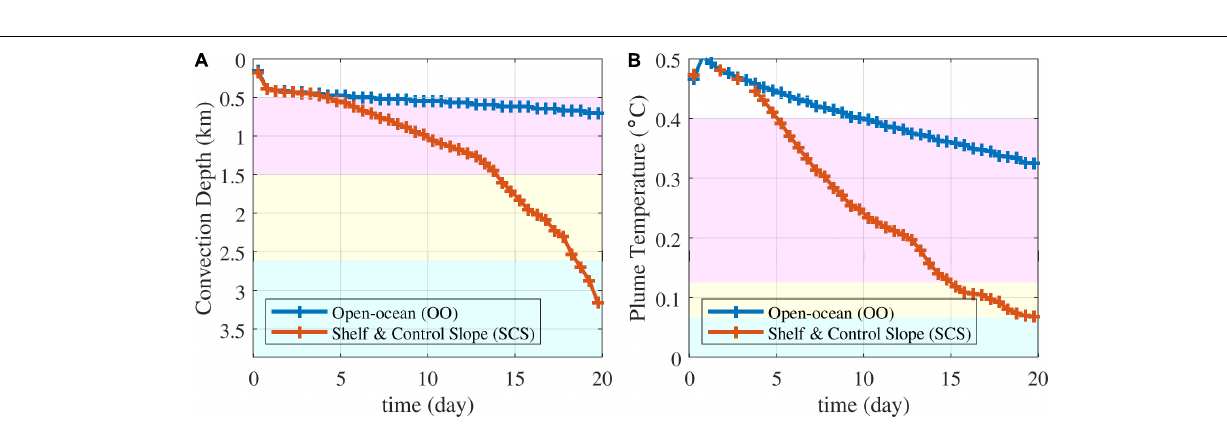
Frontiers in Marine Science |